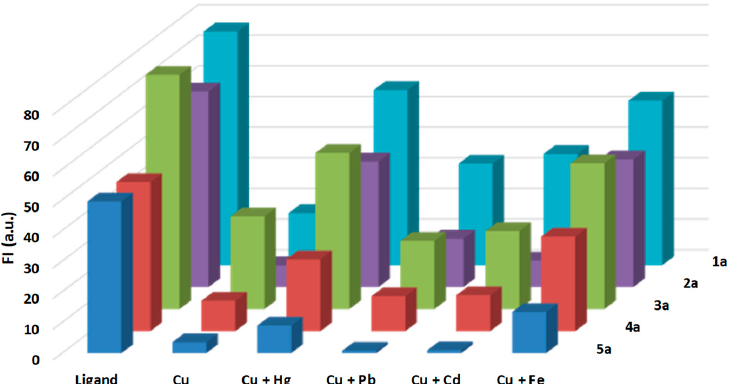
Figure 8. Fluorescence intensity profile of 1a – 5a [1 × 10 − 5 M] in water in the presence of selected metal ions [1 × 10 − 3 M].